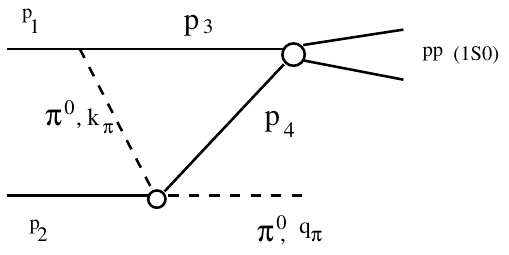
Figure 1. The OPE mechanism of the reaction pp → { pp } s π